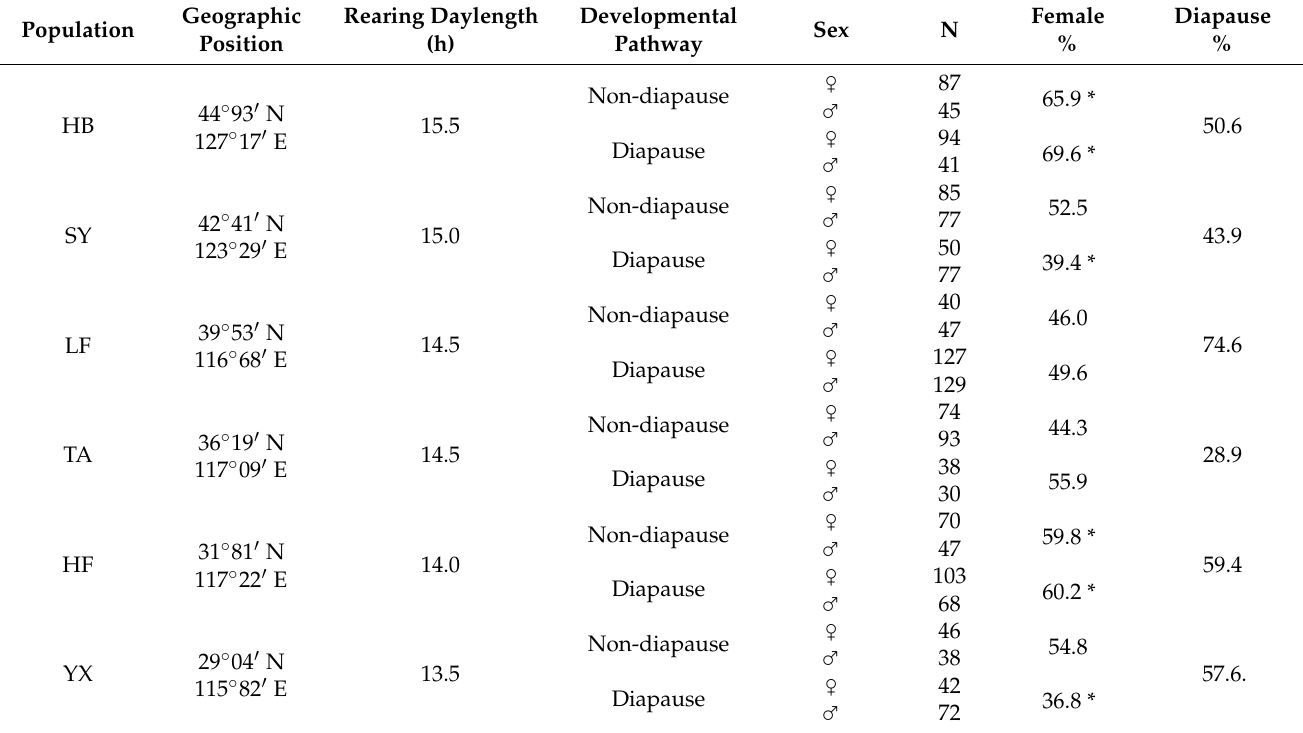
Table 1. Incidence of development pathways and sex ratio in six different populations of Ostrinia furnacalis when larvae were reared at 25 ◦ C under different daylengths that were close to their critical